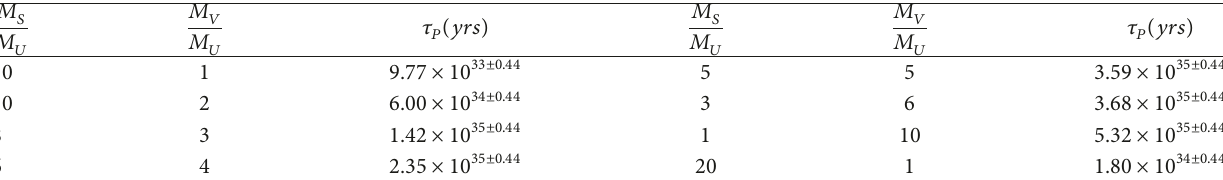
Table 5: Upper limits on predicted proton lifetime as a function of superheavy scalar (S) and gauge boson(V) mass splittings as defined in the text. The factor 10 ±0.44 represents uncertainty due to input